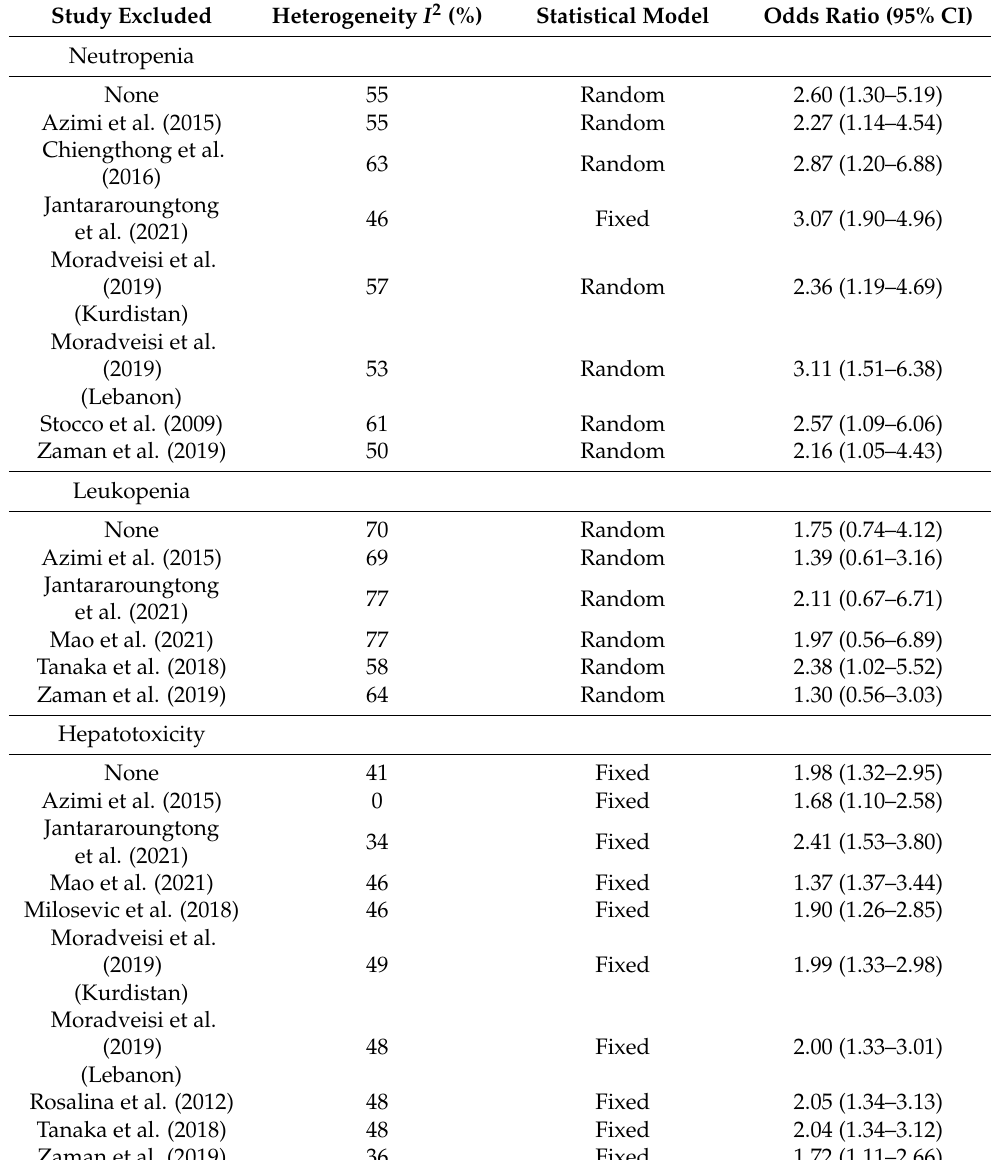
Table 2. Sensitivity analysis of the association between ITPA 94C>A status and 6-MP induced toxicities by sequentially excluding each study (ITPA wild type vs ITPA